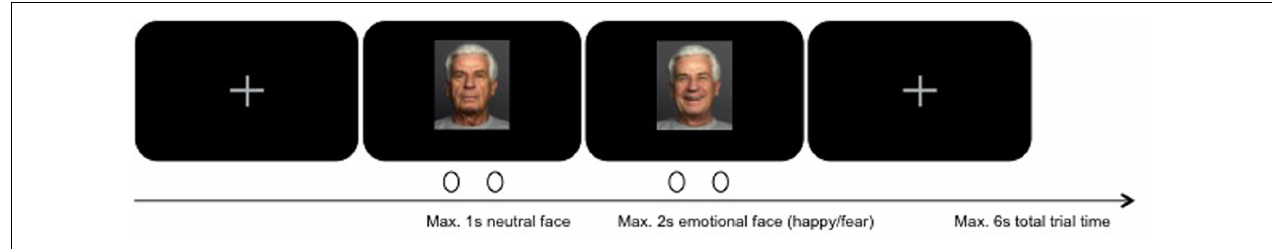
FIGURE 1 | Overview of trial design using exemplary stimulus from the FACES database kindly provided by Ebner et al. (2010).